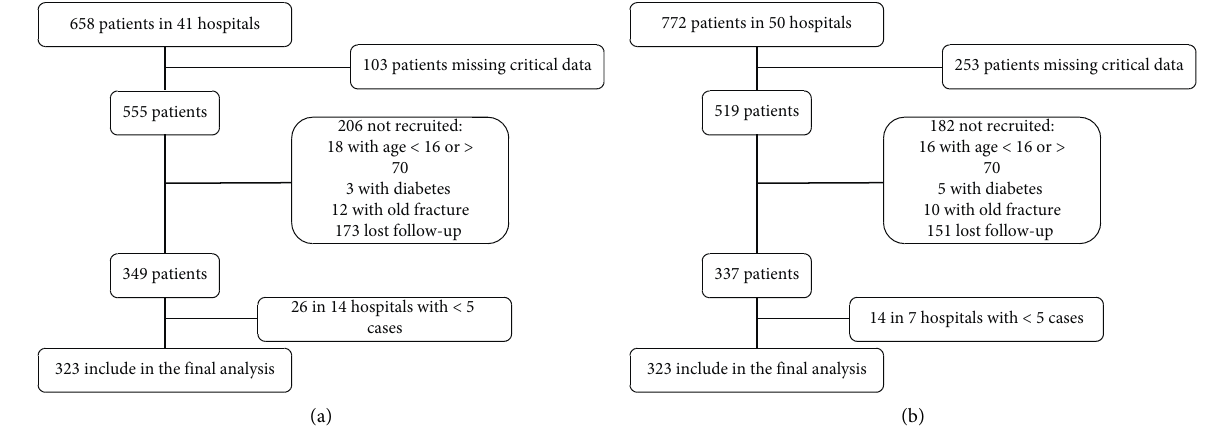
Figure 1: Schematic of included patients. Table 2: Demographic characteristics of the two groups.